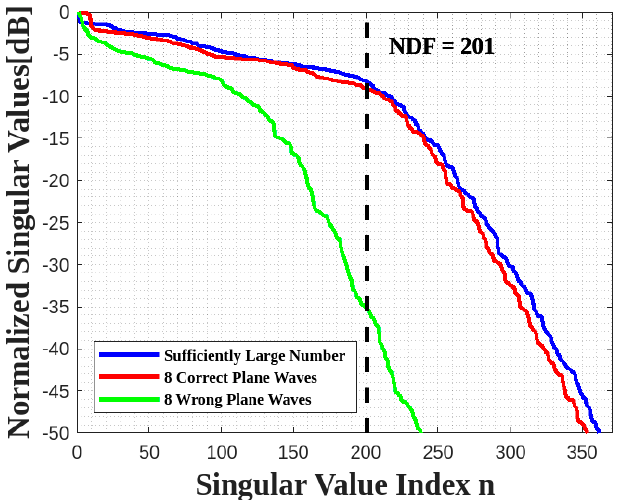
Figure 17. Comparison of the behavior of the normalized singular values for three scenarios for a XY